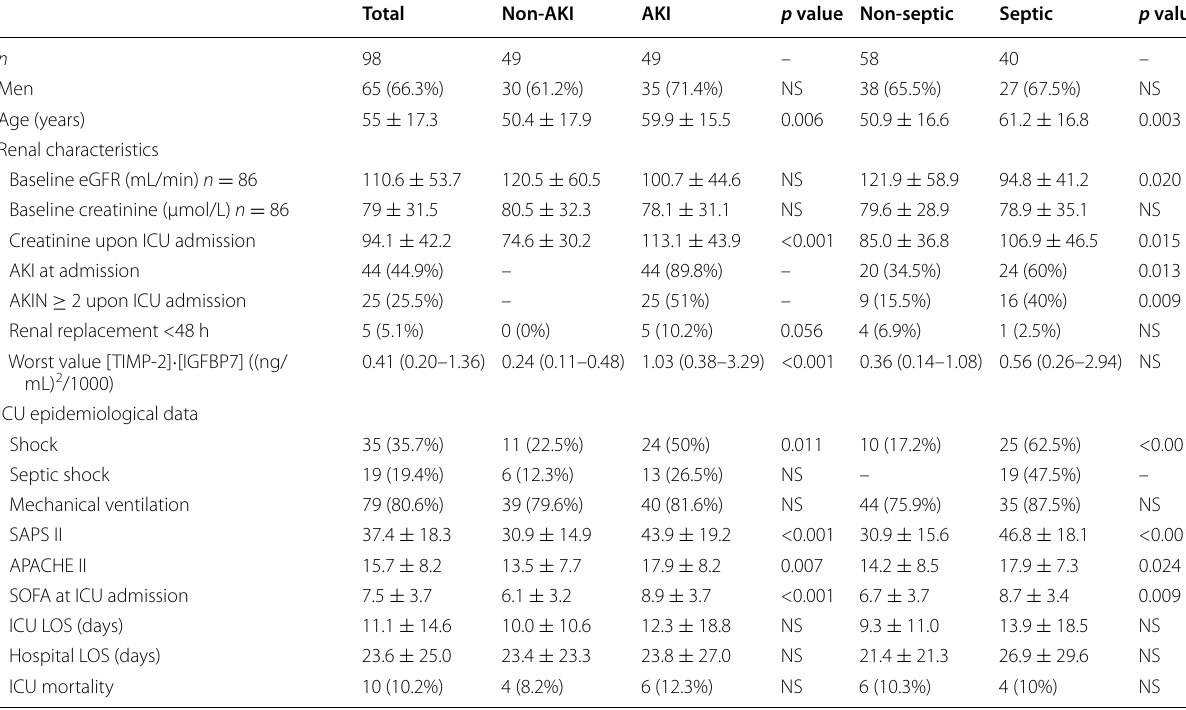
Values expressed as either % per column, mean